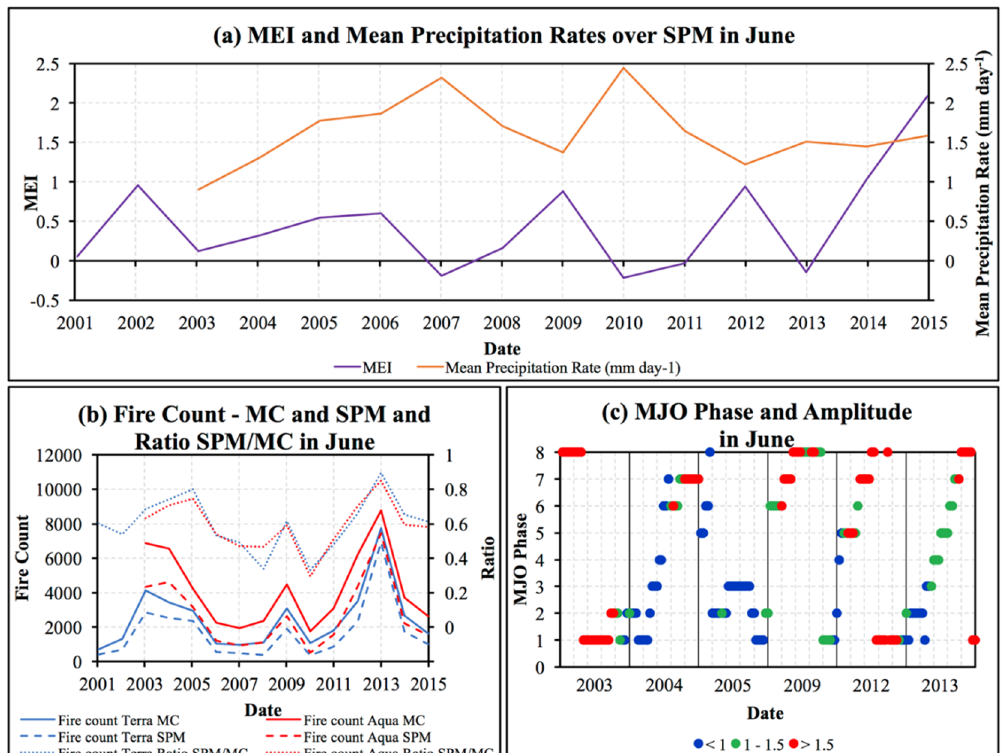
Figure 6. Time series data for ENSO, precipitation, fire over the MC and SPM, and MJO in June. ( a ) Multivariate ENSO Index (MEI) for 2001–2015 and mean CMORPH daily precipitation rate (mm day − 1 ) over SPM for the years 2003–2015. SPM for CMORPH precipitation rates include data cells over the region − 6 ◦ S to 7 ◦ N and 95 ◦ E to 107 ◦ E. ( b ) Monthly MODIS fire count for the MC and SPM, and ratio of MODIS fire count over SPM to that over MC from 2001–2015. ( c ) Wheeler index of MJO phase and colour coded amplitude for the years 2003, 2004, 2005, 2009, 2012, and